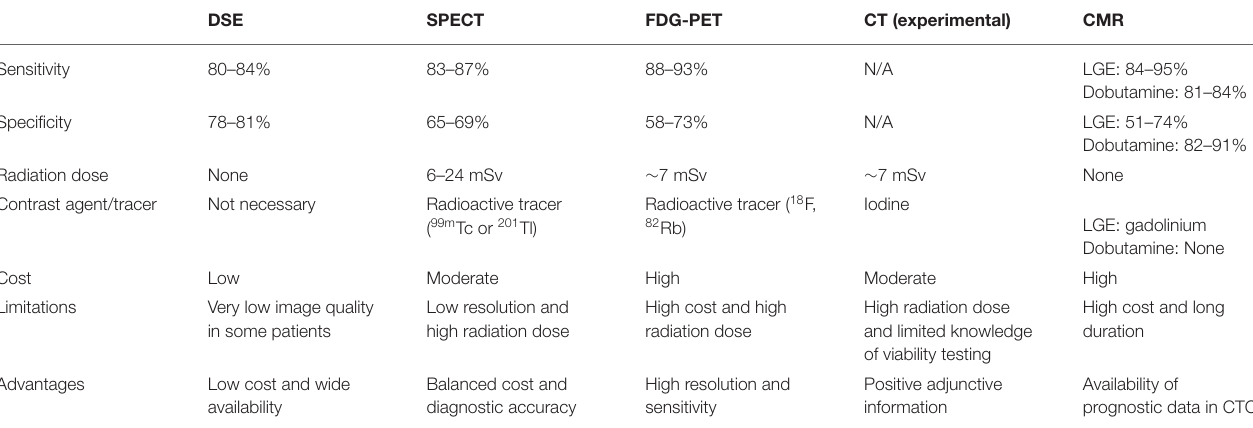
TABLE 1 | Viability testing using different non-invasive imaging